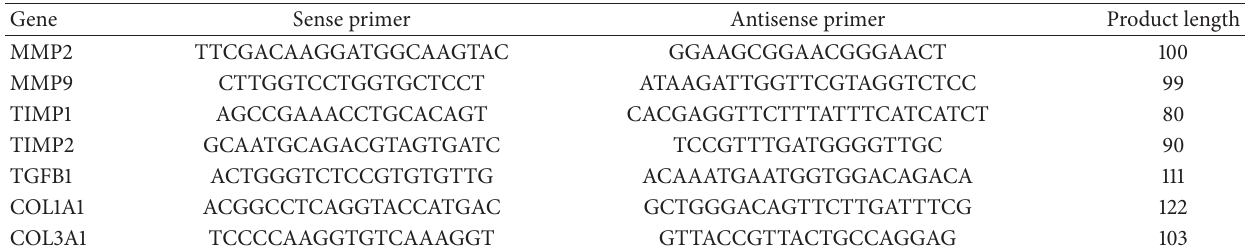
Table 1: Sequences of forward and reverse primers used for